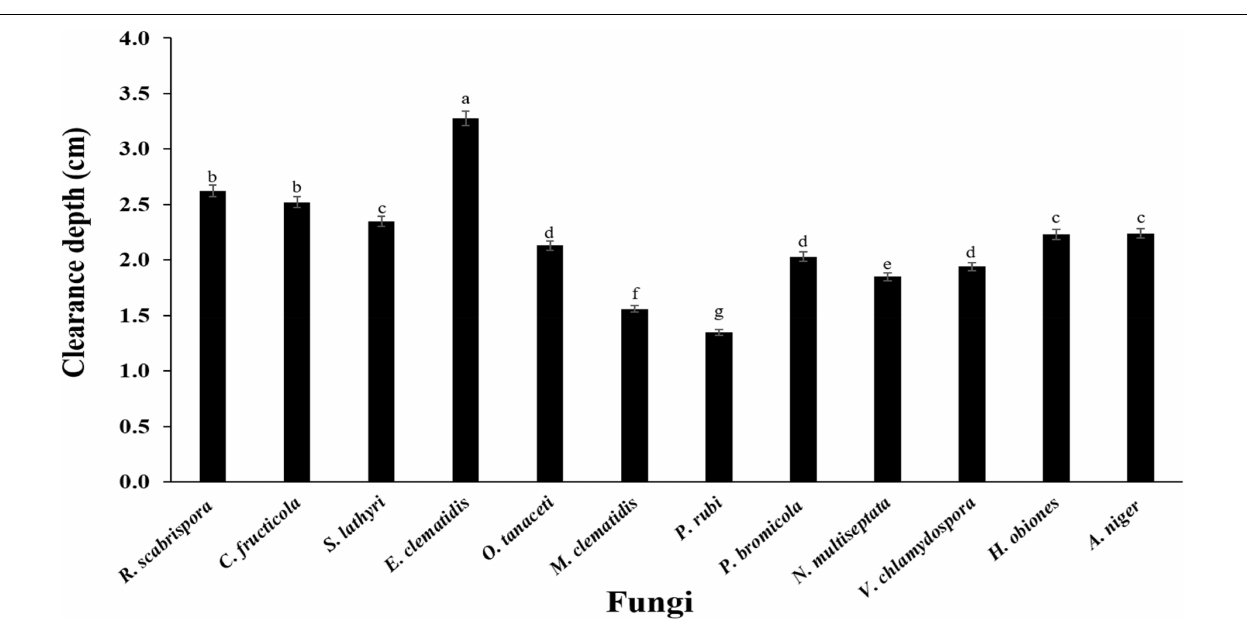
FIGURE 2 | Clearance depth of solid medium of active fungi after 2-week inoculation. Different letters indicate significant differences ( p < 0.05) (ANOVA, followed by Duncan’s multiple range